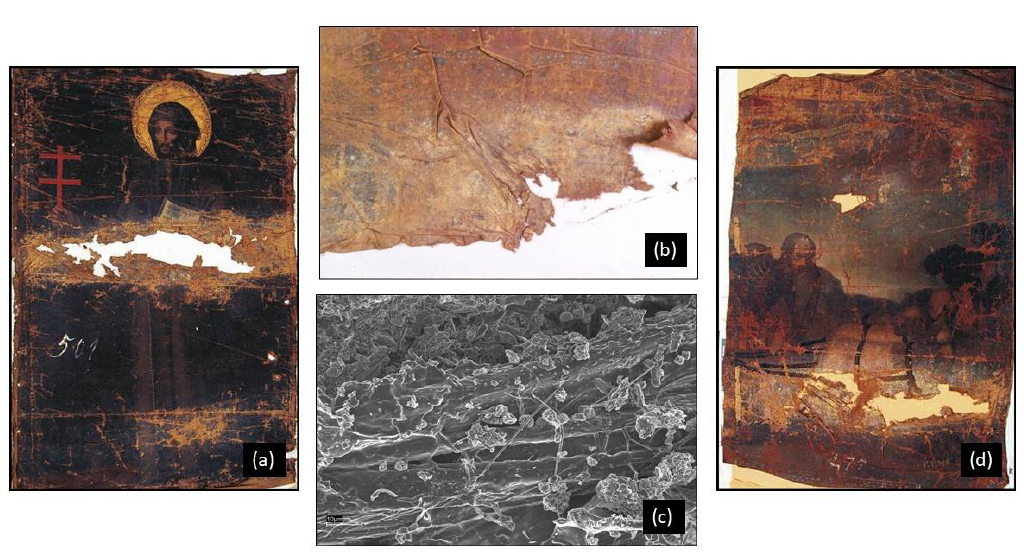
Figure 1. Overview of two paintings colonized by fungi, the St. Francis of Assisi (anonymous) ( a ) and the Allegory of Death (by P. Toma) ( b ), a detail of the biodeterioration pattern observed on the St. Francis of Assisi painting ( c ), and a SEM image of C. sitophila ( d ).